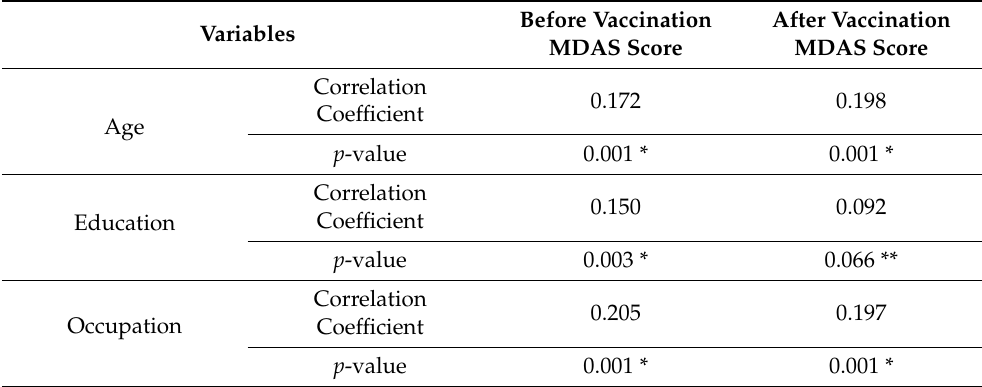
Table 4. Comparison of age, education, and occupation with anxiety scores.